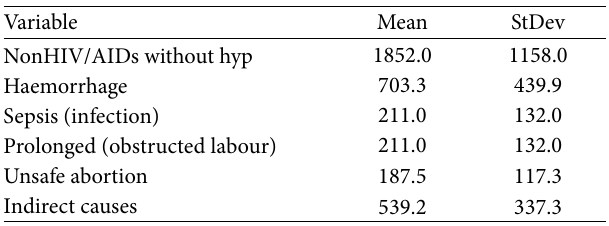
Table 1: Summary statistics of MMR and death due to haemorrhage, sepsis (infection), prolonged (obstructed labour), unsafe abortion, and indirect causes.